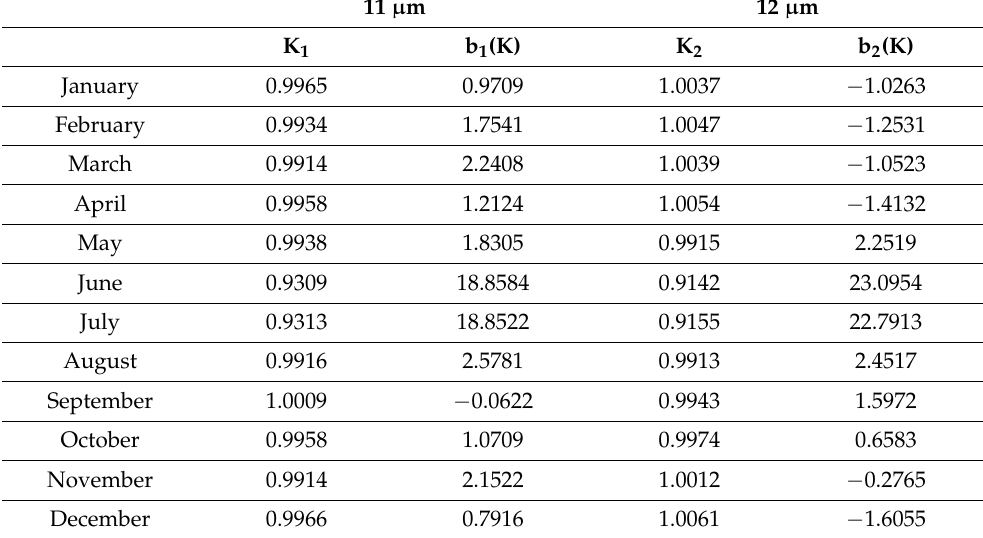
Table 3. The coefficients of the regression equation for each month.